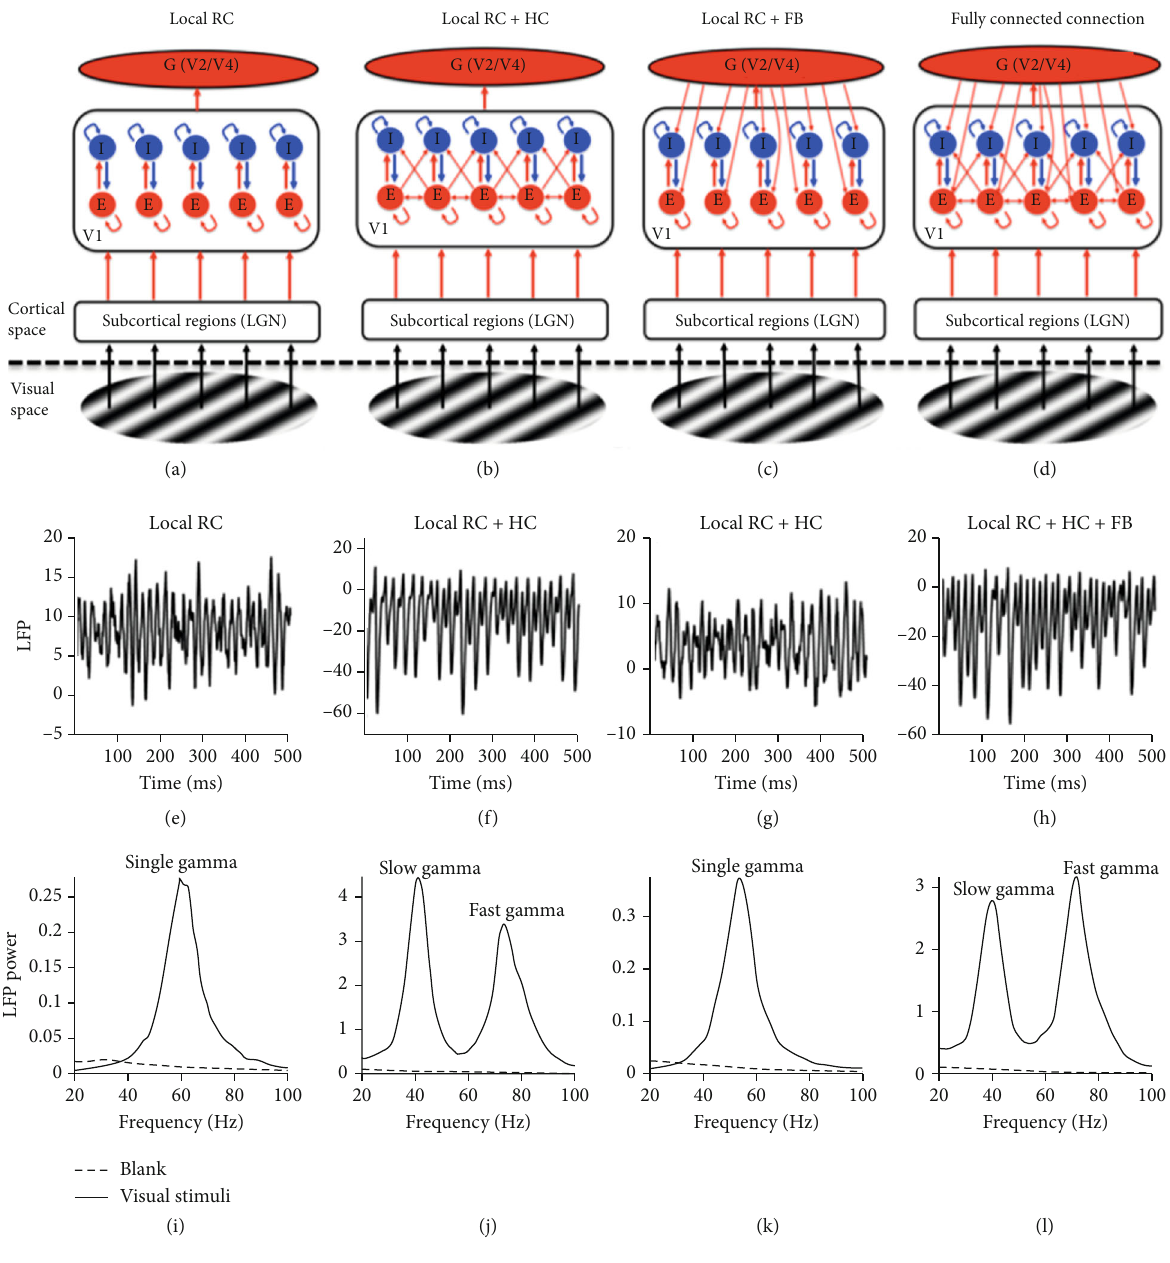
Figure 2: Gamma oscillations generated in networks with di ff erent connectivity patterns. Panels (a – d) show networks with di ff erent connection patterns. The di ff erence among (a – d) is that (a) shows a network with feedforward (FF) and local connections (local RC); (b) shows a network with local RC and long-range horizontal connection (HC) but without any feedback connection (FB); (c) shows a network with local RC and FB but without HC; and (d) shows a network with local RC, HC, and FB. The local fi eld potentials (LFP) from networks with the four di ff erent connection patterns are shown in panels (e – h) correspondingly. The power spectrums of the LFPs were estimated and shown in (i – l) ((i) for the LFP in (e); (j) for that in (f); and (k) for that in (g); and (l) for that in (h)). The black curve shows the power spectrum during the visual stimuli, while the black dashed line shows the power spectrum when networks were driven by a visual stimulus with zero contrast. There is only one gamma in (i) and (k), but two gamma oscillations (slow and fast gamma as noted) appeared in (j) and